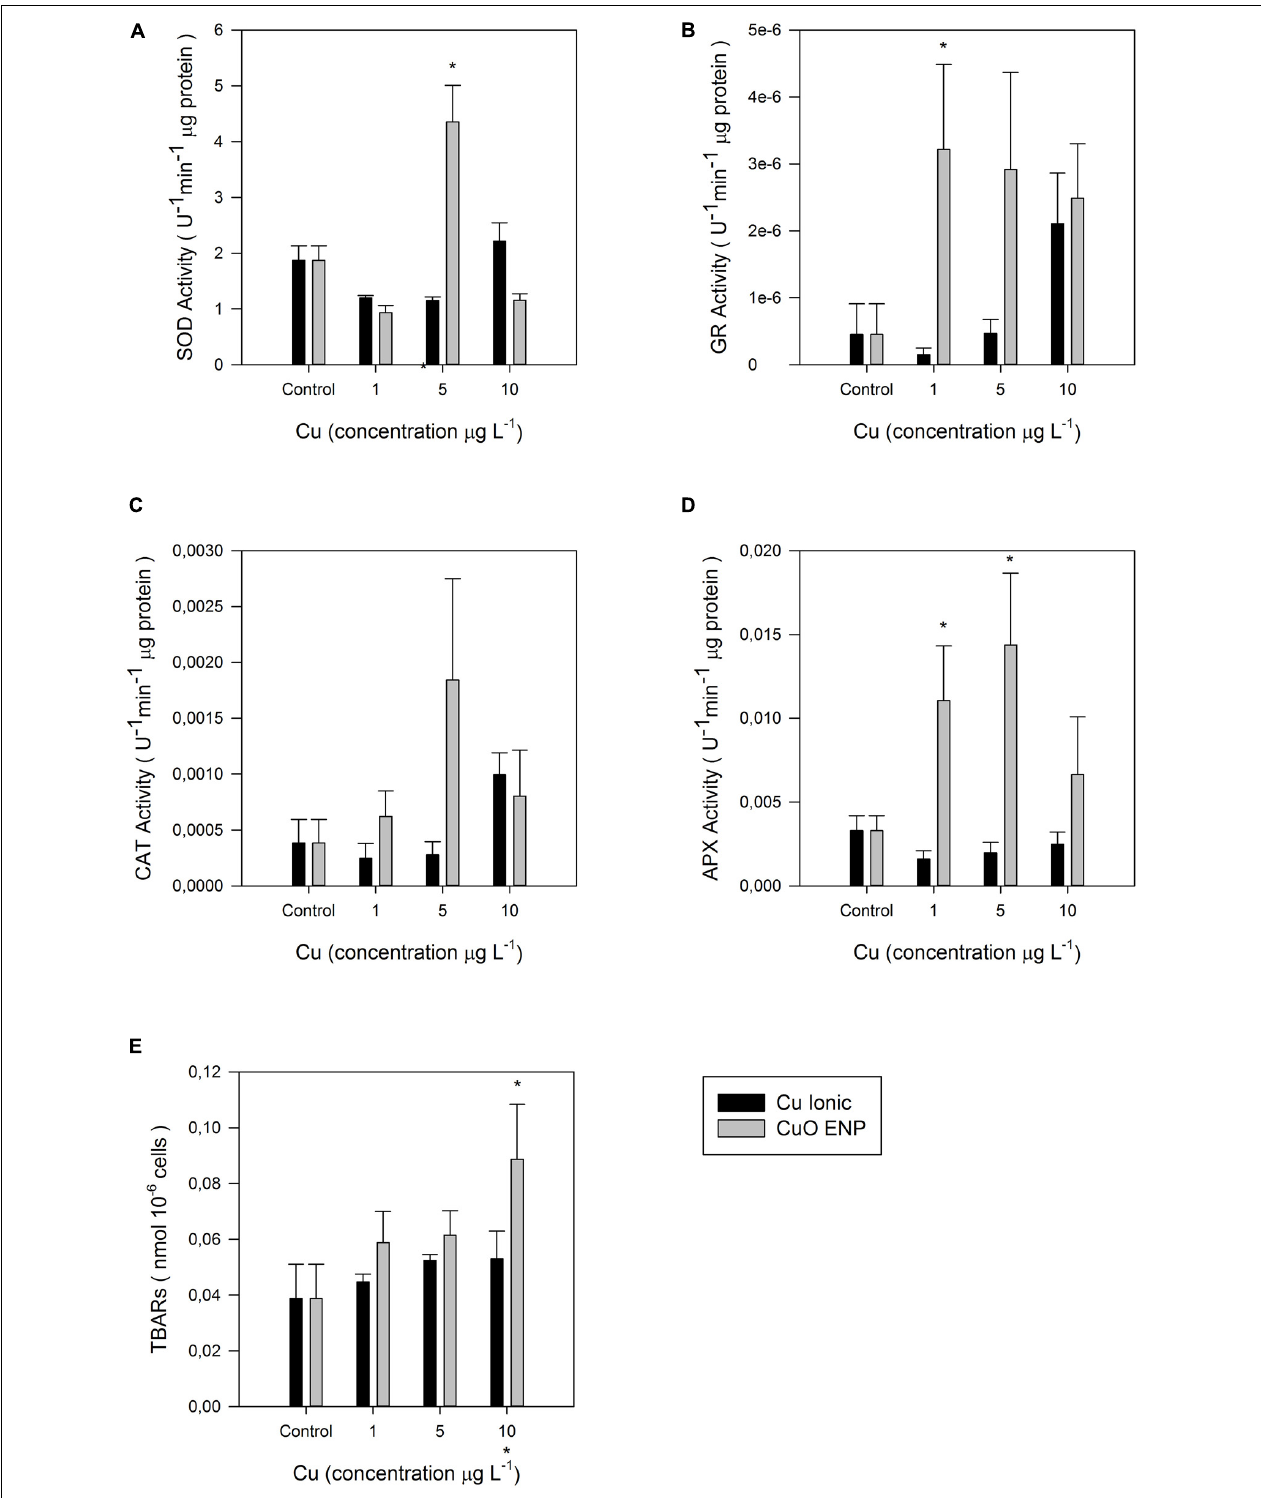
FIGURE 9 | Enzymatic activities: (A) Superoxide dismutase (SOD), (B) glutathione reductase (GR), (C) catalase (CAT), (D) ascorbate peroxidase (APX) in U - 1 µ g protein, and (E) lipid peroxidation measured as concentration of thiobarbituric acid reacting substances (TBARs; nmol 10 - 6 cells), in P. tricornutum after 3 days of exposure to increasing ionic Cu (black bars) and CuO ENP (gray bars) concentrations (average ± standard deviation, N = 3, *above bars indicate significant differences compared with the control at p < 0.05, whilst *below x -axis indicate significant differences between ionic Cu and CuO ENP at the same concentration).